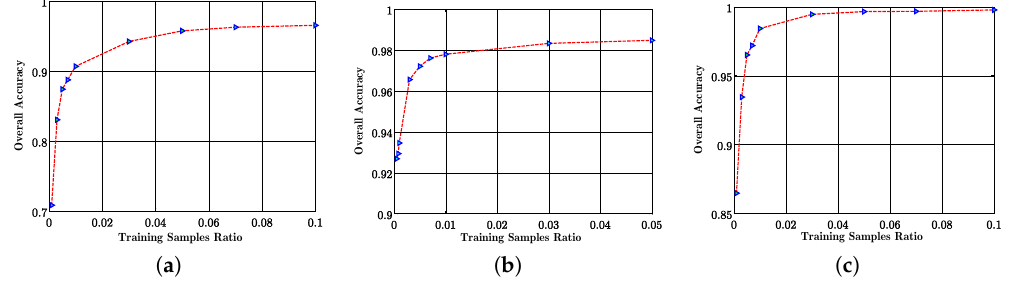
Figure 13. Overall accuracy versus different training samples ratios curves using BSLGDA+FCN on three PolSAR data sets (in their optimum dimensions). ( a ) Flevoland data set; ( b ) San Francisco data set; ( c ) Flevoland Benchmark data